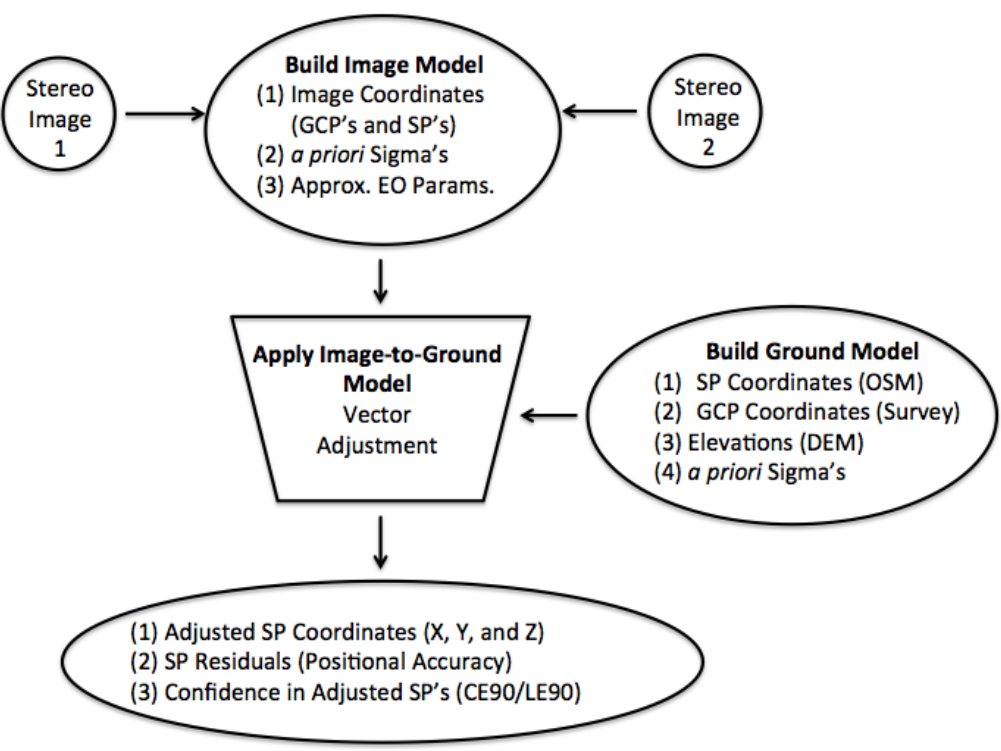
Figure 2. Schematic diagram of the vector adjustment